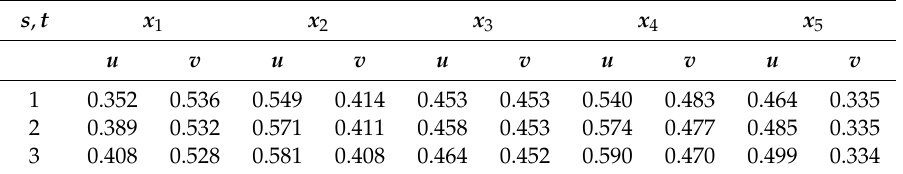
Table 2. The comprehensive attribute value of each